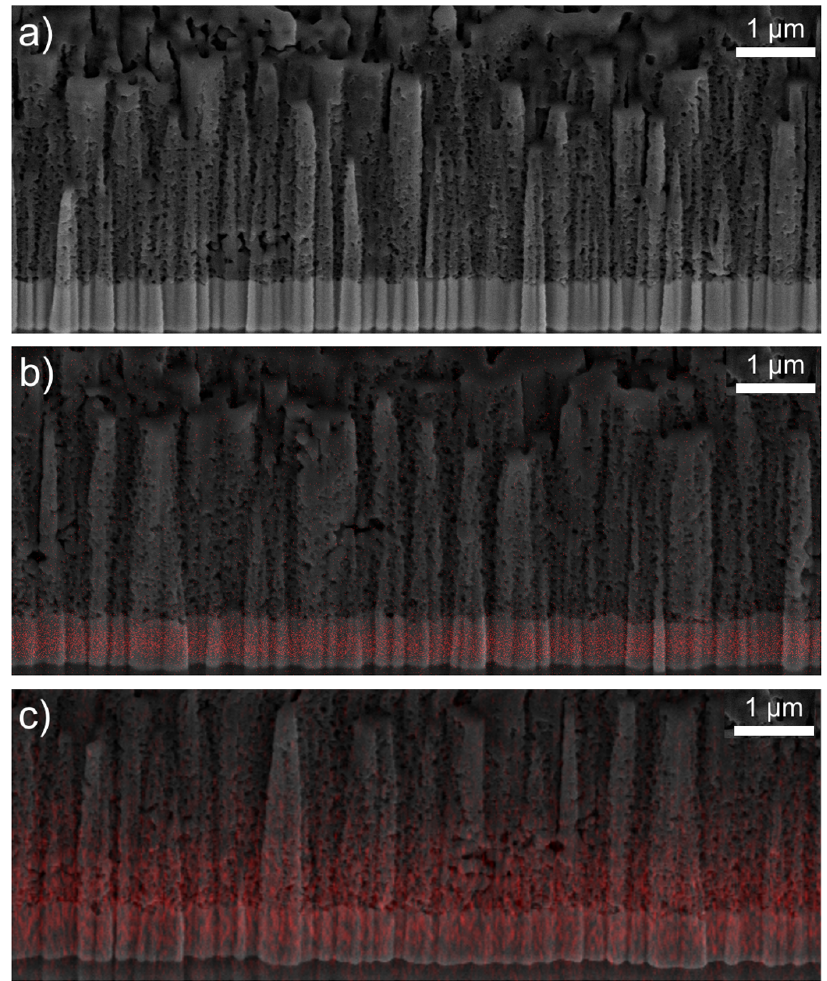
Figure 9. FIB image a) of the vertical DSC cross section; and with superimposed Sn EDX signal at b) (350 6 C) and c) (550 6 C).